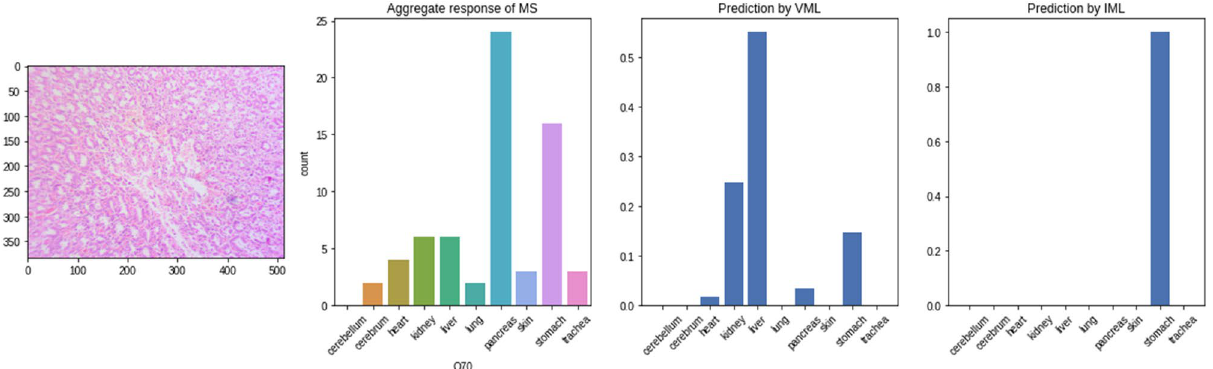
Figure 22. Stomach mucosa producing mixed response from MS, wrongly identified by VML and correctly identified by IML (Figure generated by Matplotlib python library, version 3.3.4, https:// matpl otlib. org/).